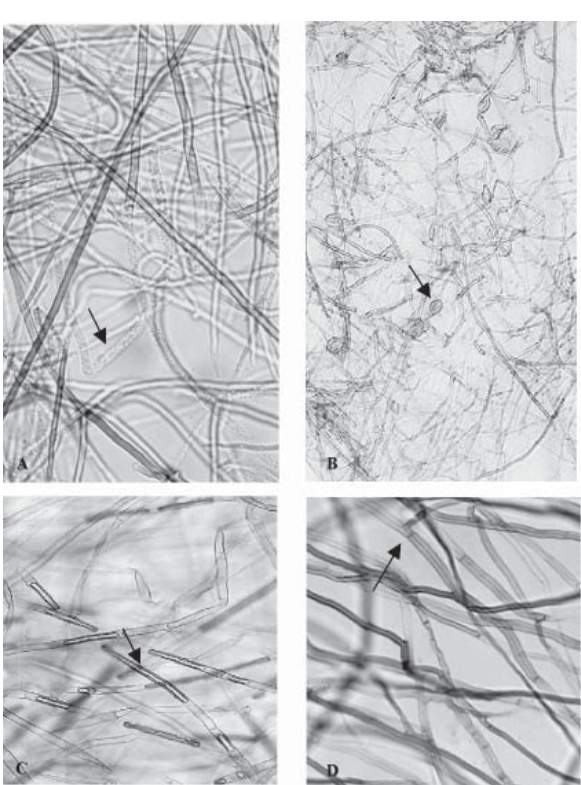
Fig. 2. Skeletal hyphae (40 (cid:1) ): A, pigmentate; B, with swellings; C, encrostate; D, generative hyphae with septa (40 (cid:1)